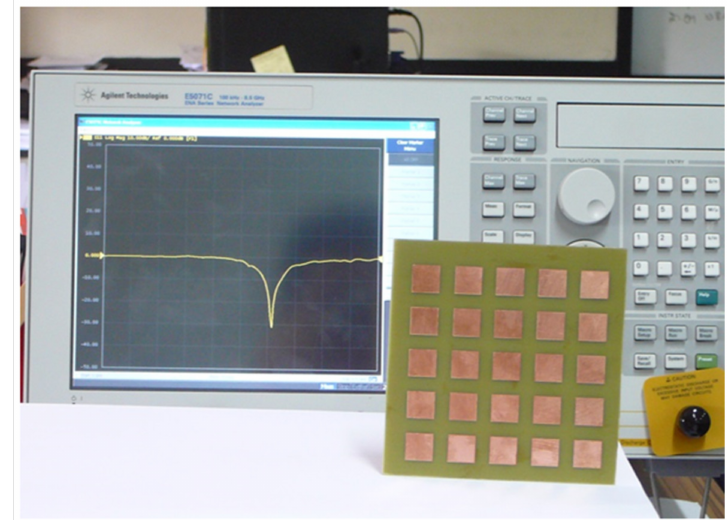
Figure 14. Measurement returns loss of an antenna prototype.